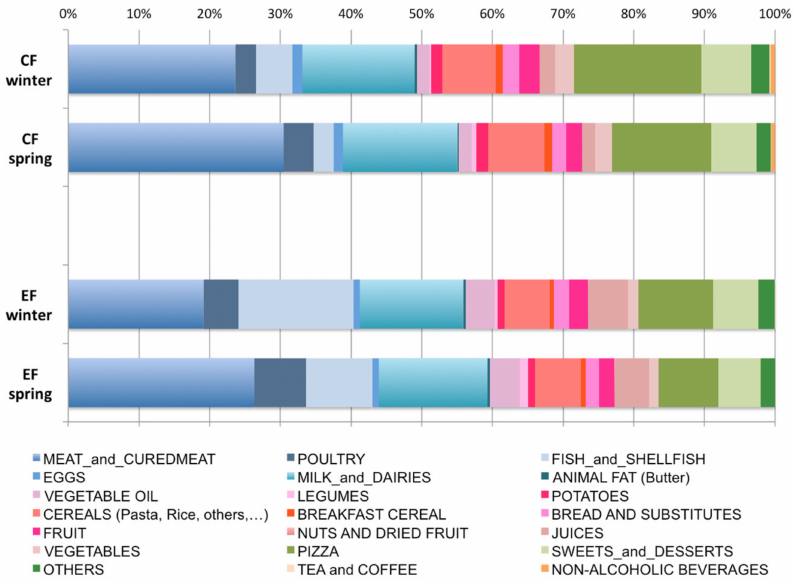
Figure 1. Relative contribution (%) of food groups to total carbon footprint (CF) and ecological footprint (EF) by seasons. Blue gradients: animal-based food; pink gradients: plant-based food; green gradients: mixed food; orange gradients: